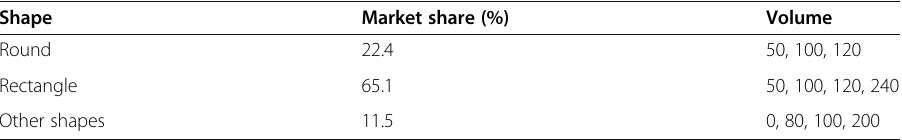
Table 3 Usage of trash bins with different shapes